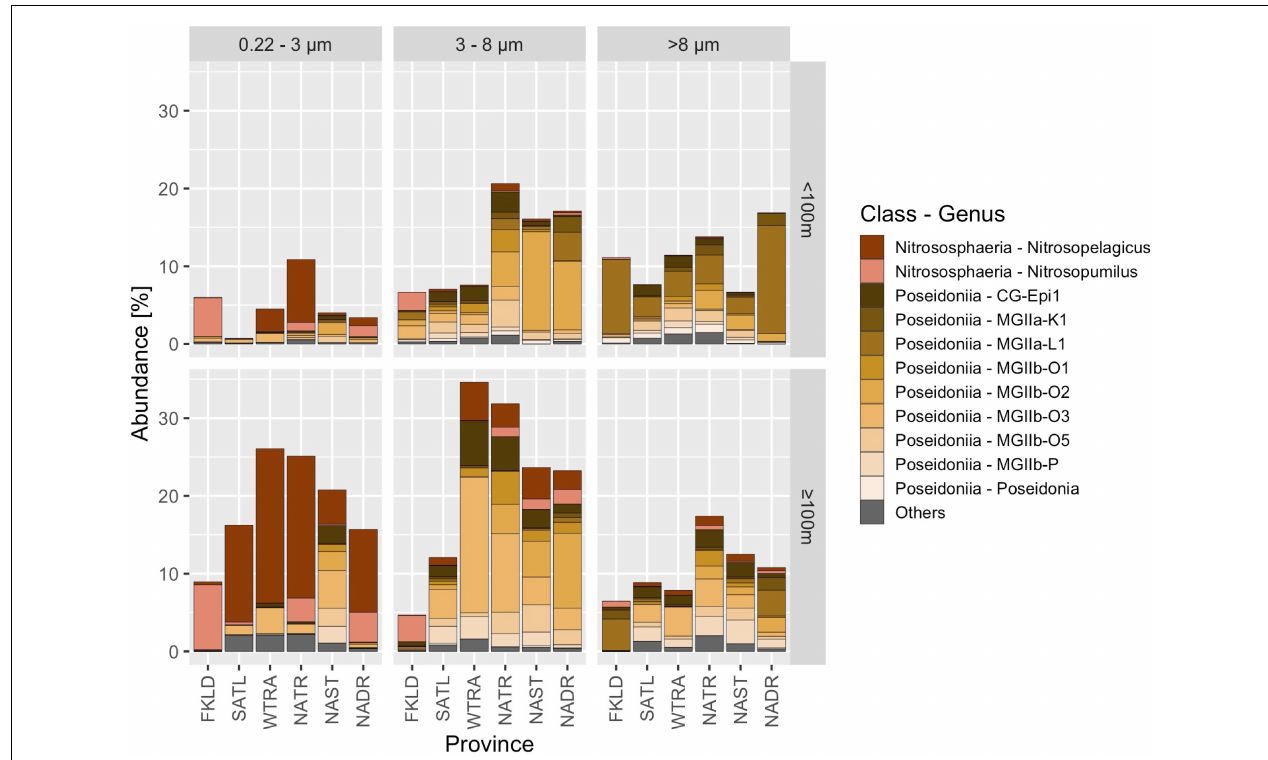
FIGURE 4 | Archaeal communities in the Atlantic Ocean. Samples were grouped according to Longhurstian province, free-living (0.22–3 µ m) and particle-attached (3–8 µ m and > 8 µ m) communities and two depths ( < 100 m and ≥ 100 m). Taxa were assigned to genera based on GTDB classification, and relative abundance is shown in% of the total abundance of prokaryotes in that sample. Sequences were obtained with the V4-V5 primers. All archaeal genera that had an abundance below 0.5% within the prokaryotic dataset were grouped into